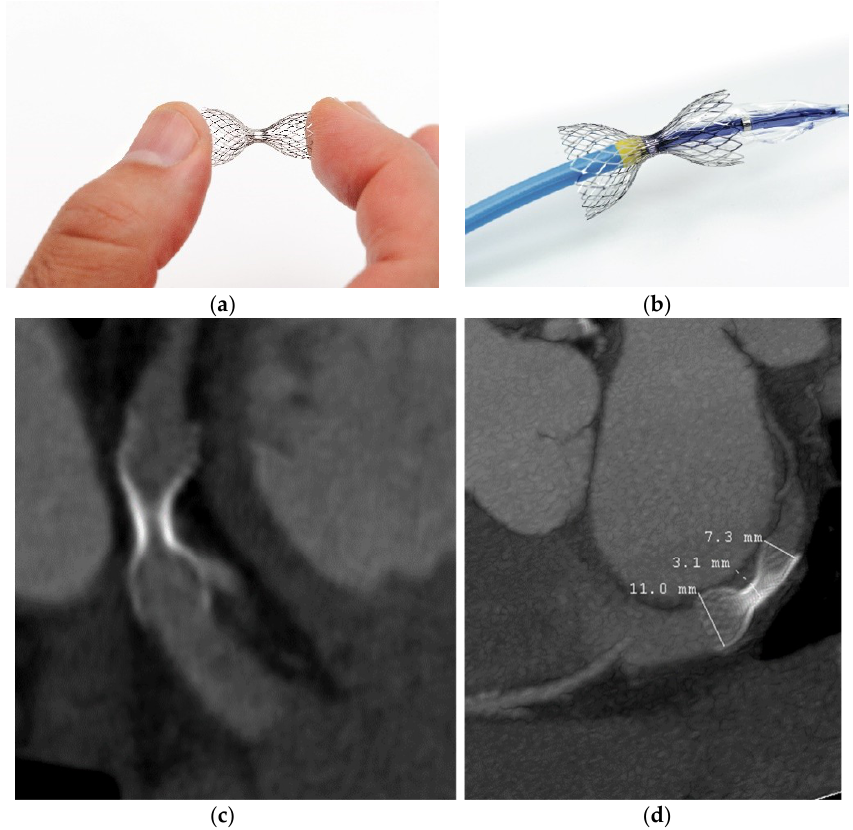
Figure 1. The Sinus Reducer Device (Neovasc Inc. Richmond, Canada) is a stainless steel, hourglass-shaped, balloon-expandable mesh designed to create focal luminal stenosis in the coronary sinus (top left and right). Computer tomography image of the coronary sinus after 1-year follow-up (bottom left and right). ( a ). The sinus reducer; ( b ). the sinus reducer as mounted on its delivery balloon. ( c ). and ( d ). computer tomography after implantation.